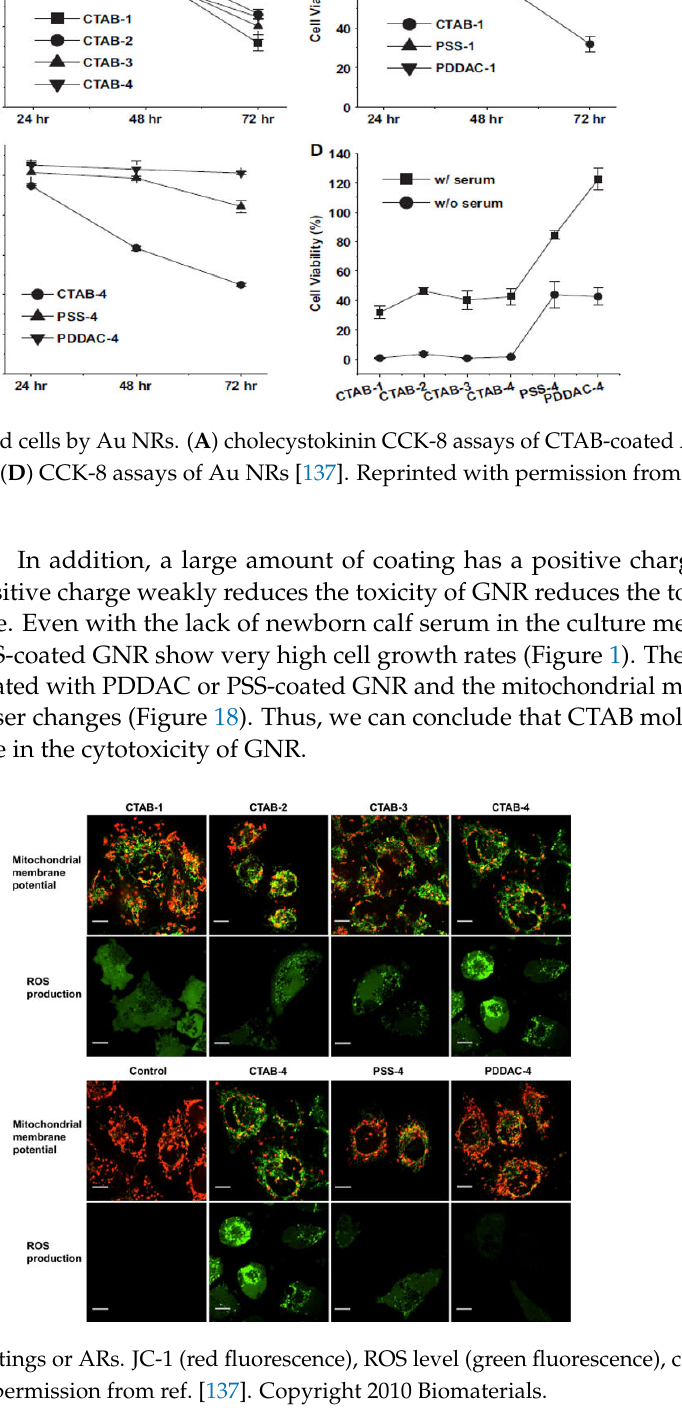
Figure 18. GNR of different coatings or ARs. JC-1 (red fluorescence), ROS level (green fluorescence), causing mitochondrial damage [137]. Reprinted with permission from ref. [137]. Copyright 2010